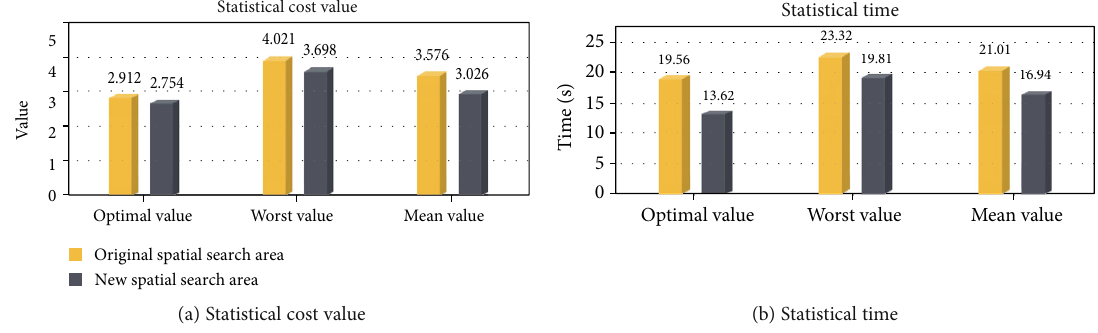
Figure 26: The statistical results of two di ff erent spatial search areas.